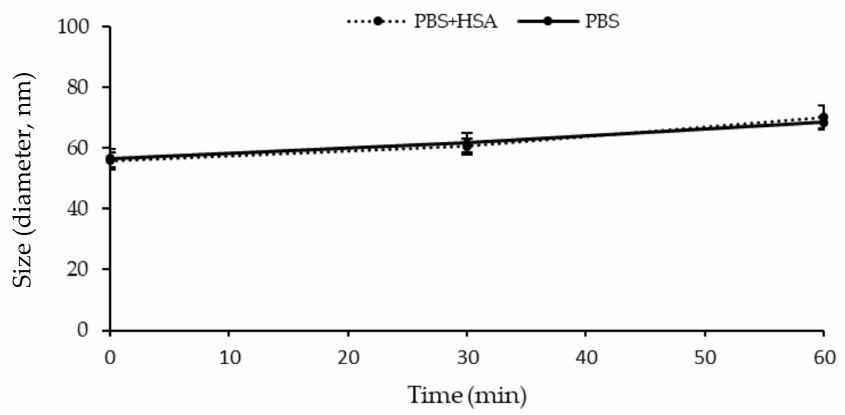
Figure 5. Stability of TQ-SSM in PBS and PBS + HSA for 1 h.